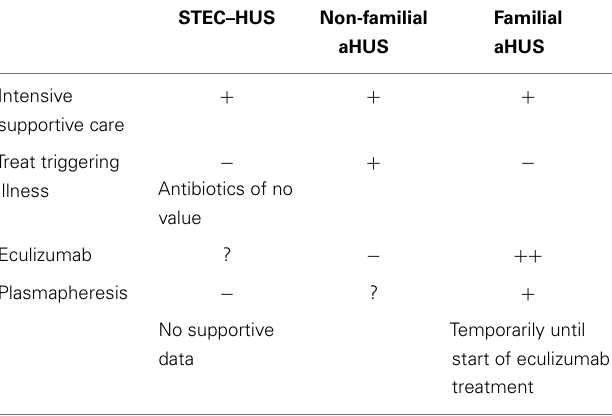
Table 3 | Overall approach to the treatment of children with HUS